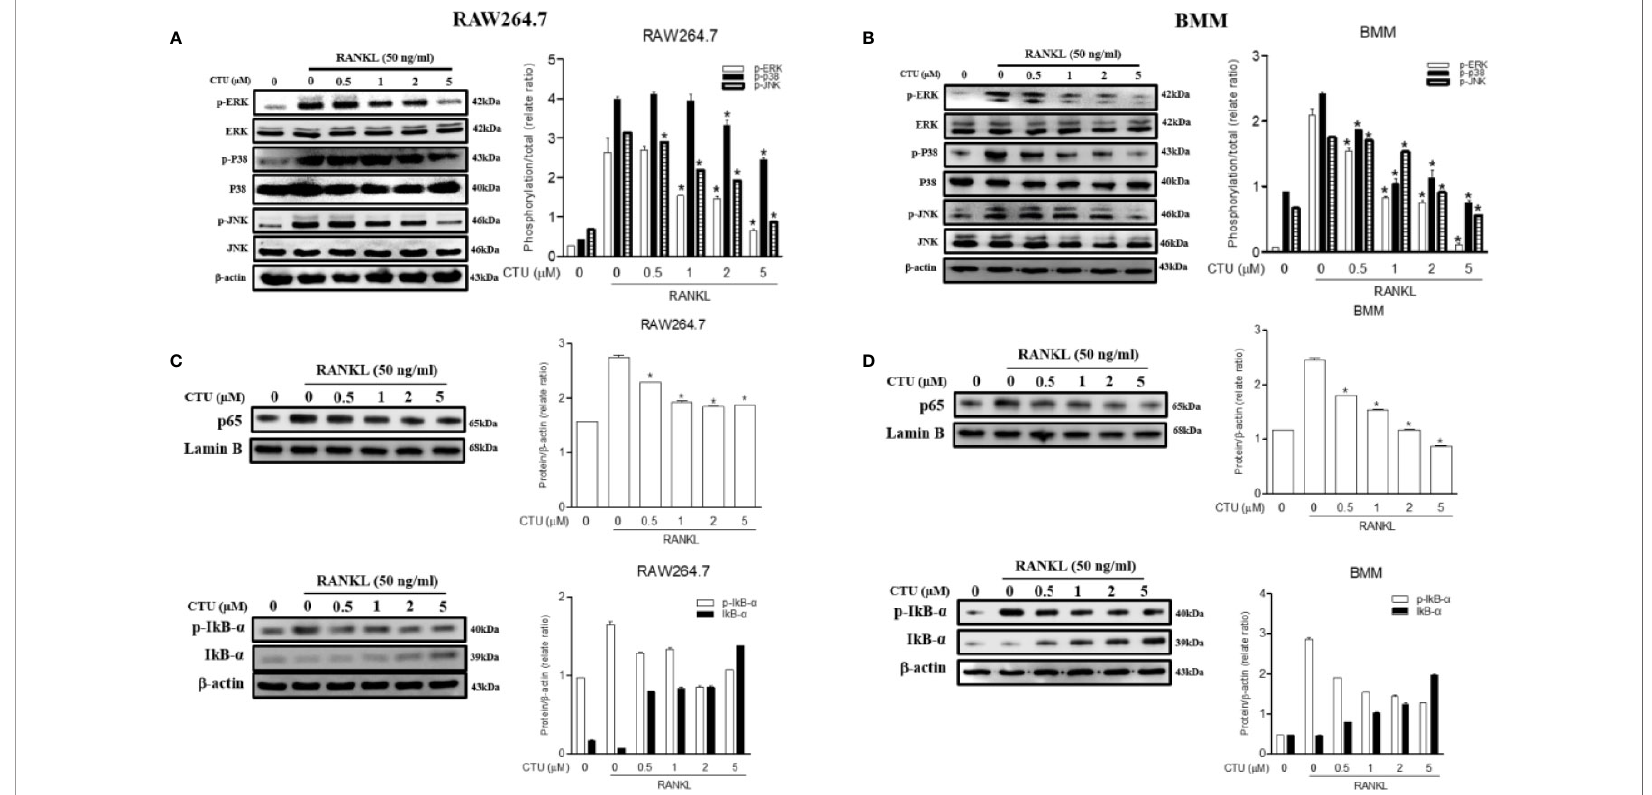
FIGURE 8 | Effect of CTU on MAPKs (A, B) and NF-kB (C, D) activation in RANKL-induced RAW 264.7 and BMM cells. The cells were pre-incubated with or without CTU for 2 h, followed by treatment with 50 ng/ ml RANKL for 30 min. The protein expression of cytosolic and nuclear p65, I к B¥á, and p-I к B¥á was compared with that of controls subjected to western blot analysis. *p < 0.05 compared with the only RANKL- treated